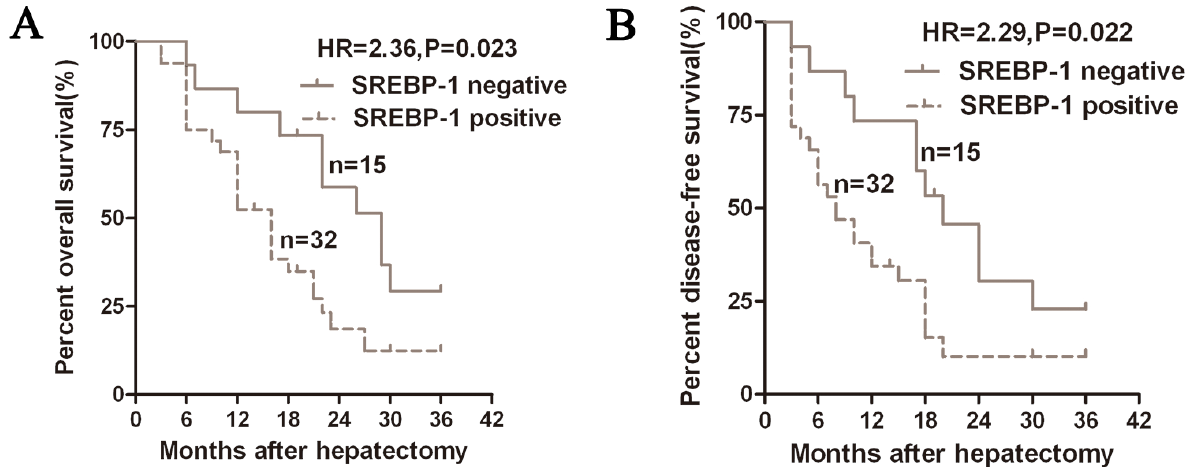
Figure 2. Kaplan-Meier 3-year overall ( A ) and disease-free ( B ) survival curves of HCC patients according to the status of SREBP-1 protein expression. The SREBP-1 positive expression group ( n = 32), IHC score of SREBP-1 ≥ 1; SREBP-1 negative expression group ( n = 15), IHC score of SREBP-1 = 0.